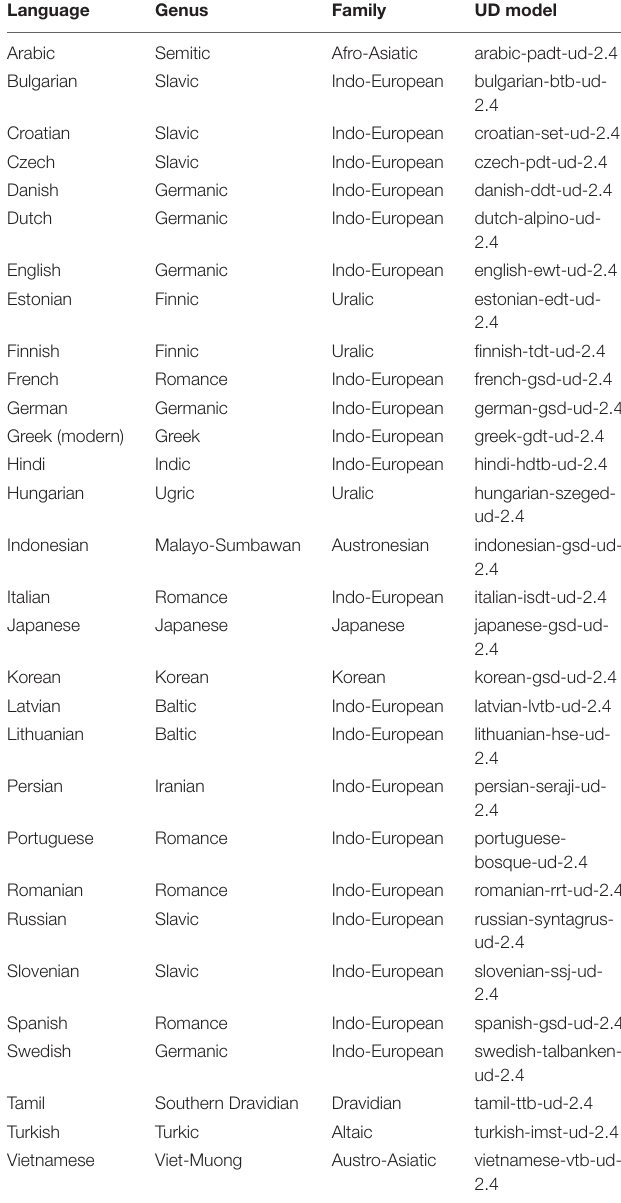
TABLE 1 | Languages in this